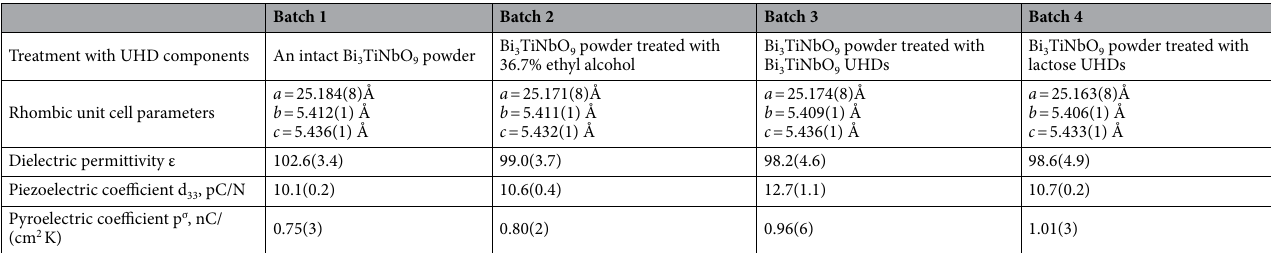
Table 1. Synthesis conditions, structural and electrophysical characteristics of different series of BTN samples. Data are presented as average, n = 10–18 repeated measurements. The numbers in brackets represent an approximation of the numerical value of statistical margin (± for the last significant